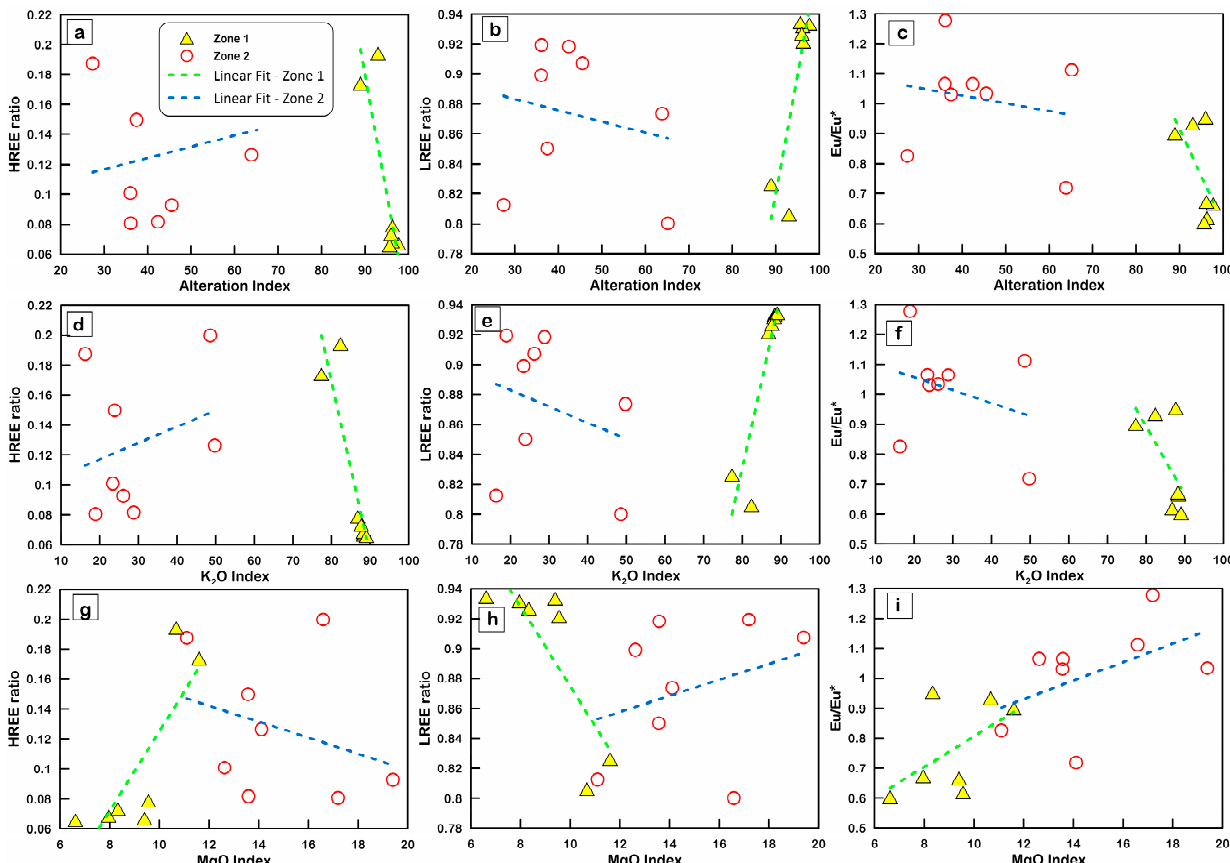
Figure 16. ( a ) The alteration index (A.I.) vs. HREE ratio. ( b ) The alteration index (A.I.) vs. LREE ratio. ( c ) The alteration index (A.I.) vs. Eu-anomaly (Eu/Eu*). ( d ) K 2 O index (K.I.) vs. HREE ratio. ( e ) K 2 O index (K.I.) vs. LREE ratio. ( f ) K 2 O index (K.I.) vs. Eu-anomaly (Eu/Eu*). ( g ) MgO index (M.I.) vs. HREE ratio. ( h ) MgO index (M.I.) vs. LREE ratio. ( i ) MgO index (M.I.) vs. Eu-anomaly (Eu/Eu*).